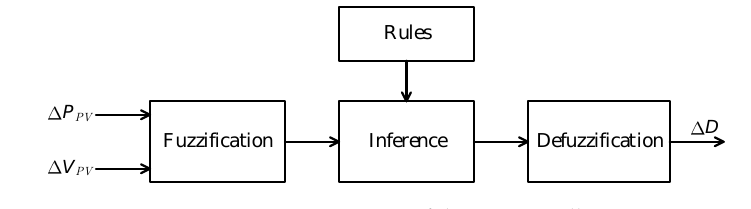
Figure 8. Basic structure of the FL